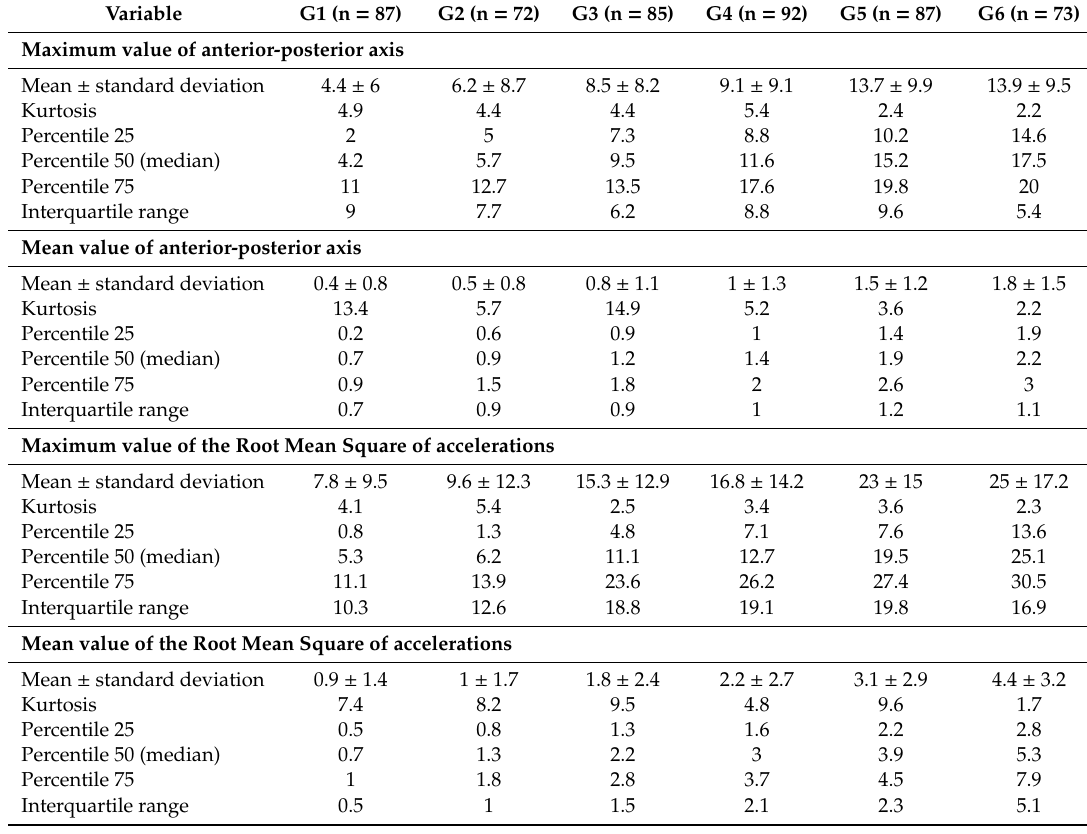
Table 2. Percentiles and descriptive statistics for the monopodal balance test with open eyes by age